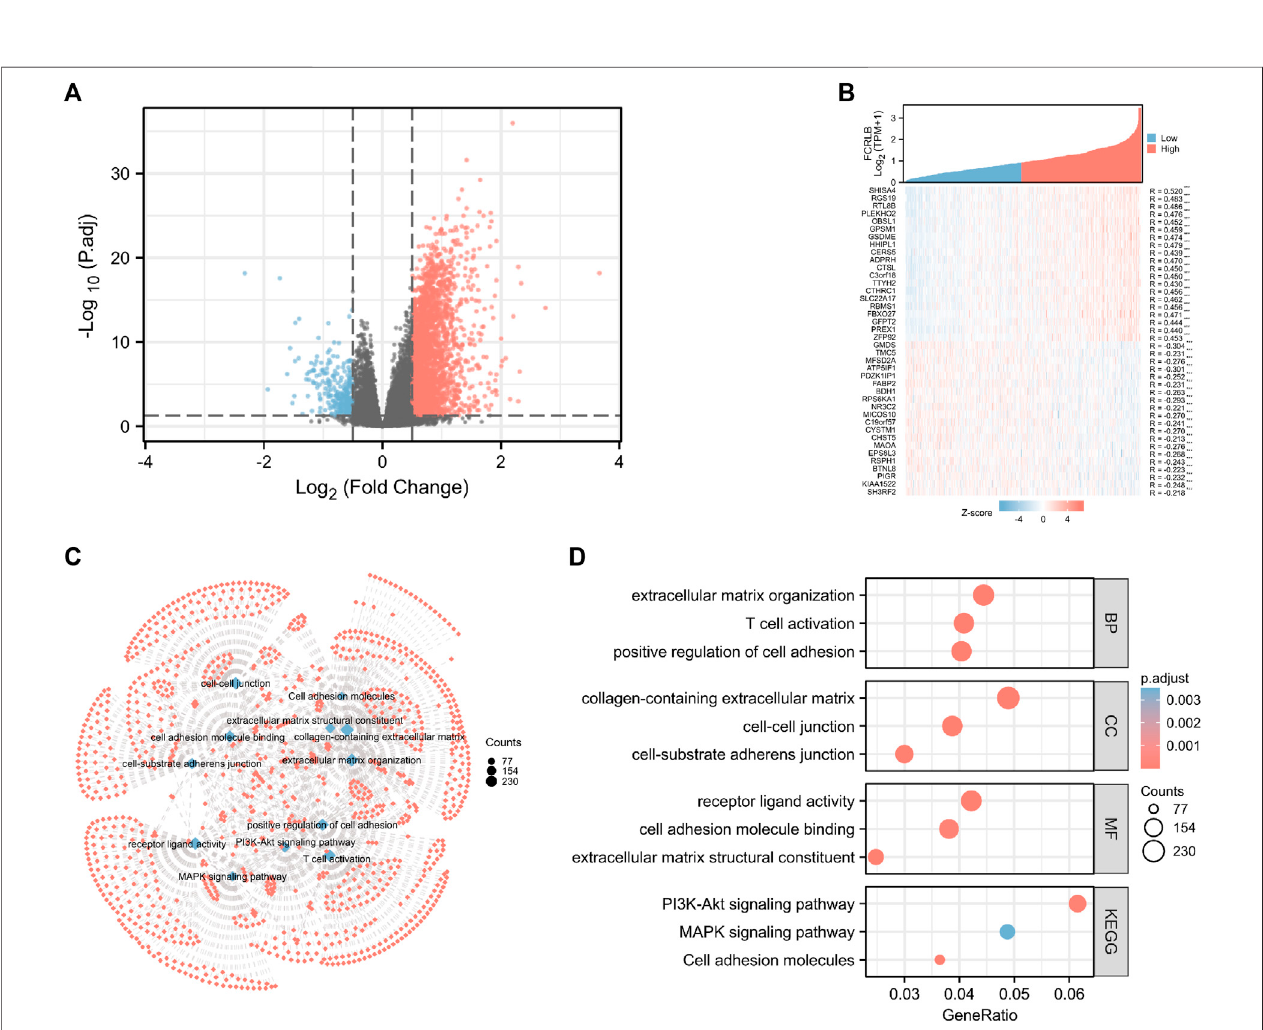
FIGURE 7 | Functional and pathway annotation among the high and low FCRLB groups by GO and KEGG analysis. (A) The volcano plot showed the DEGs identi fi ed between high and low FCRLB groups in the TCGA CRC cohort. The red and blue dot represents the up-regulated gene and down-regulated gene with signi fi cance, respectively, and each grey dot represents genes that did not meet the preset parameters (|log2(FC)| > 1 and p. adj < 0.05). (B) Gene expression heat map and correlations for FCRLB co-expressed genes. * p < 0.05, ** p < 0.01**, and * p < 0.001. (C,D) The top 12 signi fi cant terms of GO and KEGG pathway analyses. The results were presented in a network diagram (C) and a bubble chart (D) ,